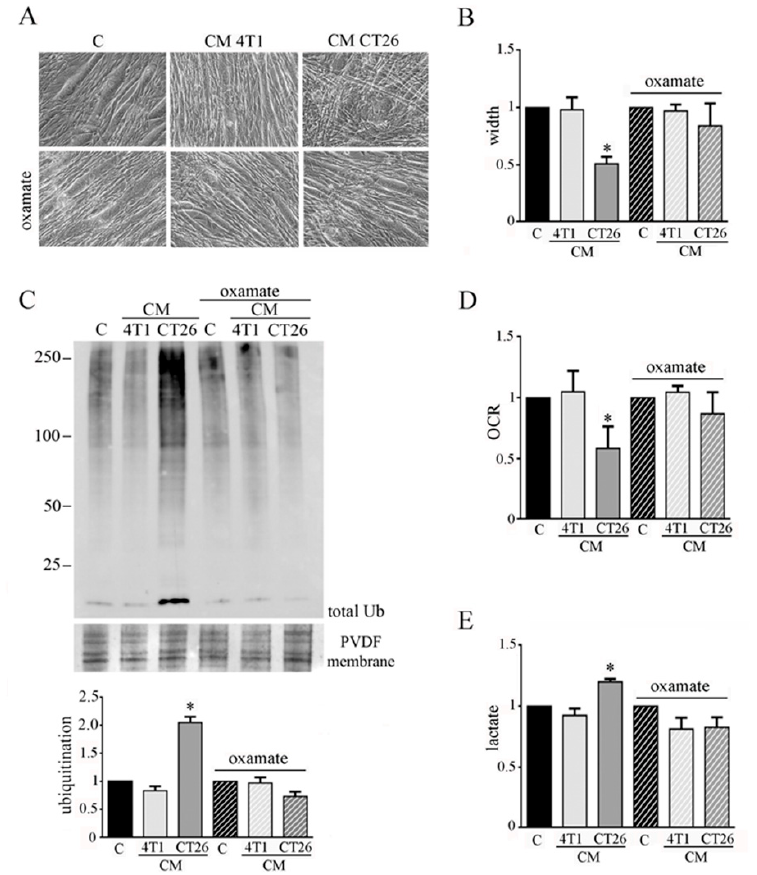
Figure 3. LDH inhibition impedes CM-CT26-induced cachexia. Four-day-differentiated myotubes were treated with CMs figure 24 h. Untreated myotubes (indicated with C) are maintained in differentiating medium for the same period. Where indicated, the LDH inhibitor’s oxamate (75 mM final) was added to the culture media. ( A ) Representative optical microscope images of CM-treated myotubes in the presence of oxamate. Scale bar: 100 µ m. ( B ) Analysis of oxamate effect in myotube width. ( C ) Ubiquitination level in myotubes. Total ubiquitination level, reported in the bar